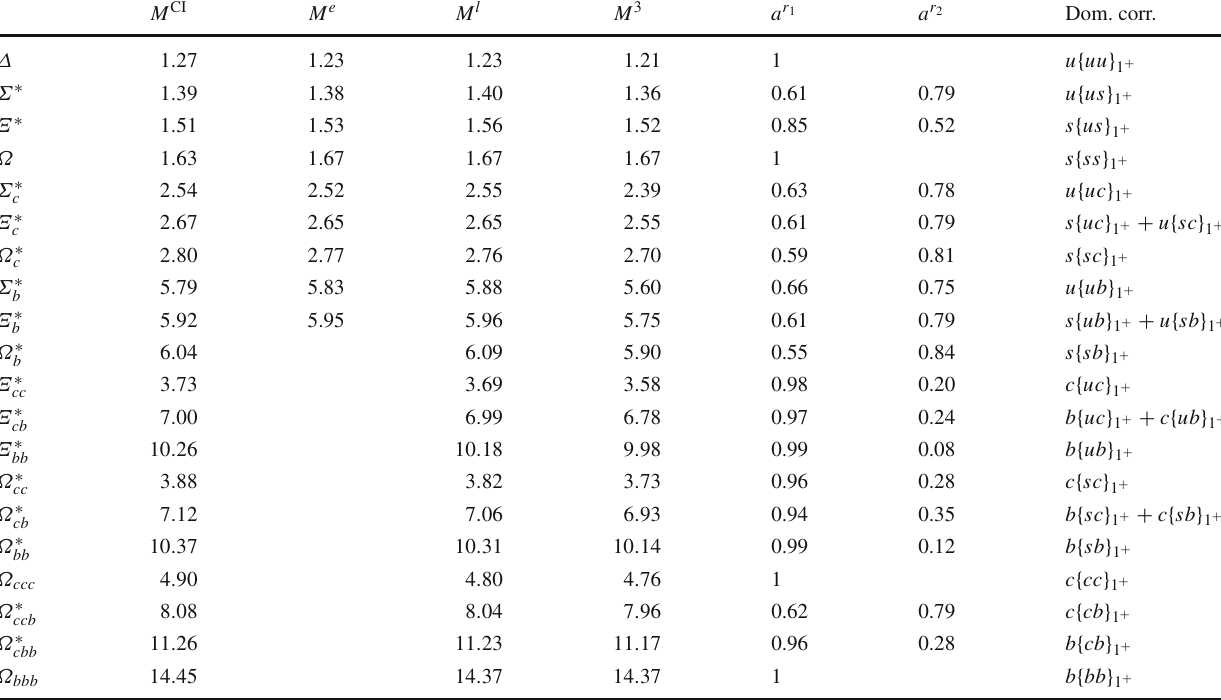
Table 4 Computed mass and Faddeev amplitude for each ground-state flavour-SU ( 5 ) J P = 3 / 2 + baryon. The last column highlights the baryon’s dominant spin-flavour correlation. The possibilities are given in Eqs.(B.10), (B.12), (B.14), (B.16). Empirical mass values, M e , are